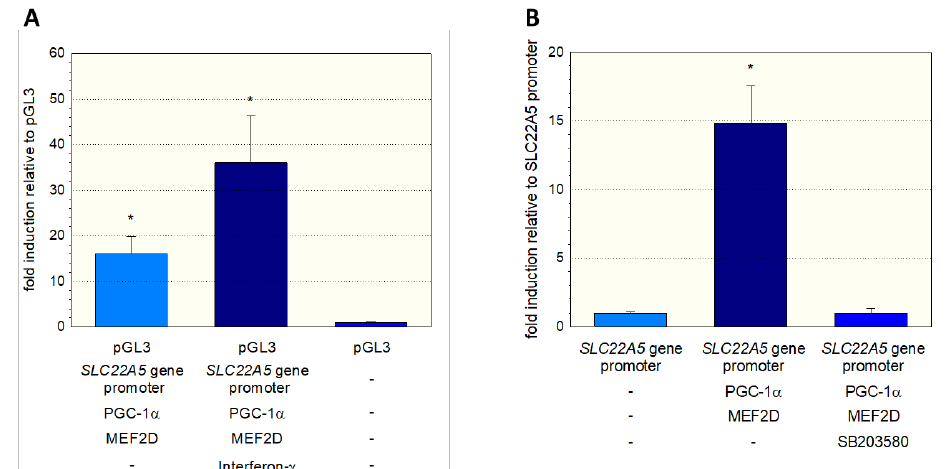
Figure 6. Interaction of the SLC22A5 gene promoter activity with p38 MAPK. C2C12 myoblasts were transfected with the SLC22A5 gene promoter, and the functionality assessed using a dual luciferase assay. ( A ) Interferon- γ , which activates p38 MAPK, increases the activity of the SLC22A5 gene promoter in C2C12 cells overexpressing PGC-1 α and MEF2D. ( B ) The specific p38 MAPK inhibitor SB203580 blocks the stimulation of the SLC22A5 gene promoter activity. Data are presented as the mean ± SD of n = 5 independent observations. * p < 0.05 vs. pGL3 (empty vector).